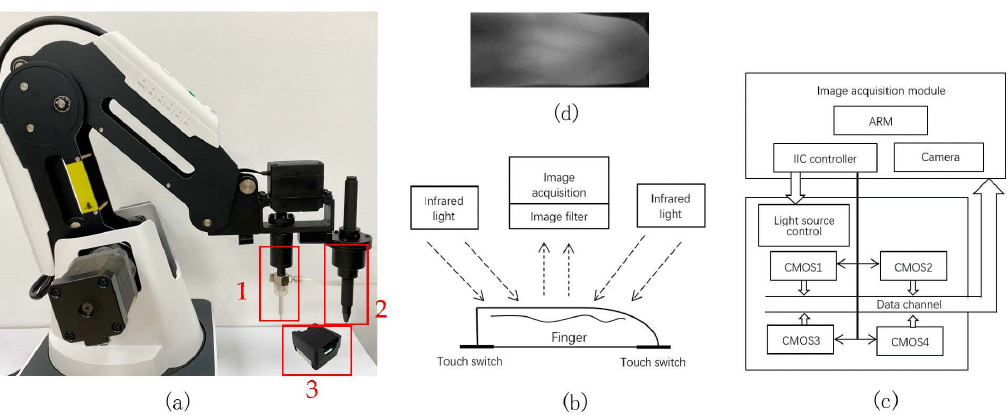
Figure 1. Finger vein imaging and blood sampling device. ( a ) Mechanical arm, ( b ) Reflection infrared imaging of finger-vein, ( c ) Circuit structure of imaging module, ( d ) Infrared image of finger-vein.